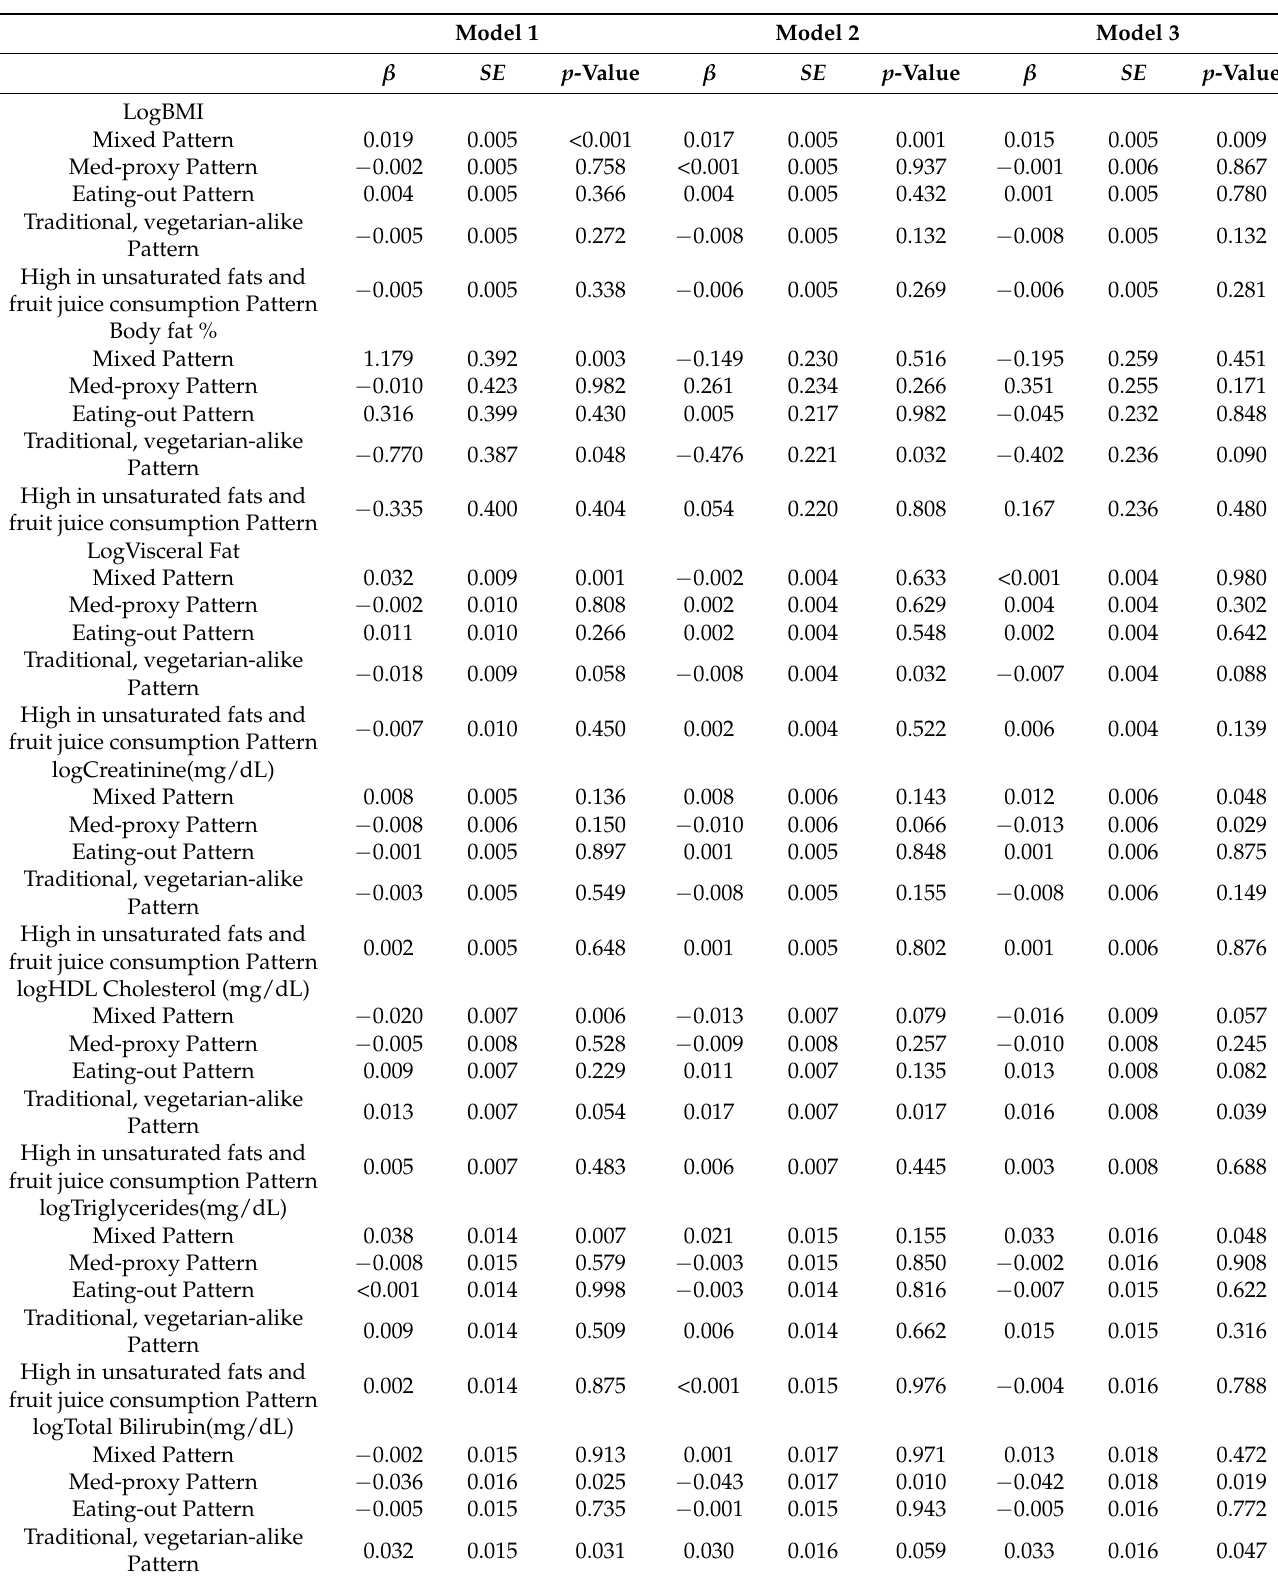
Table 5. Multivariate linear regressions between the extracted dietary patterns and indices of anthropometric and biochemi- cal